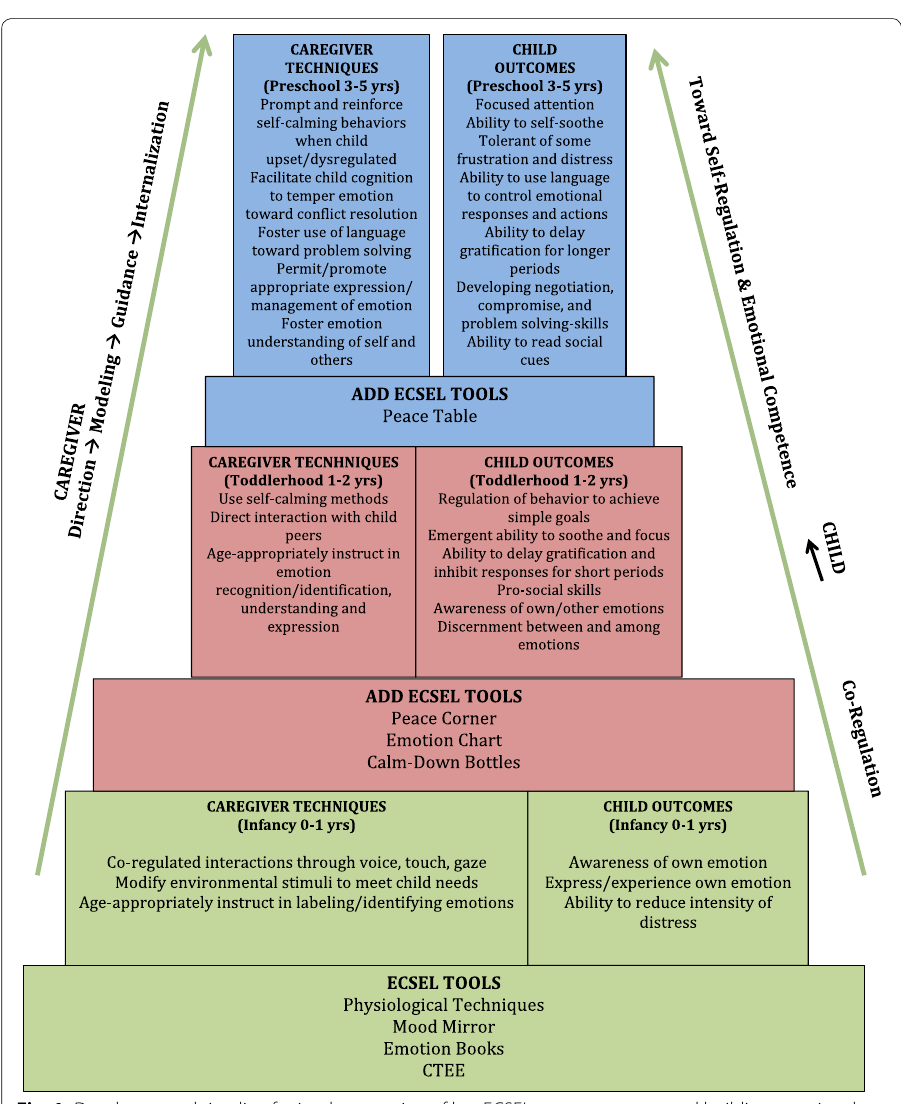
Fig. 1 Developmental timeline for implementation of key ECSEL components toward building emotional competence on the path toward